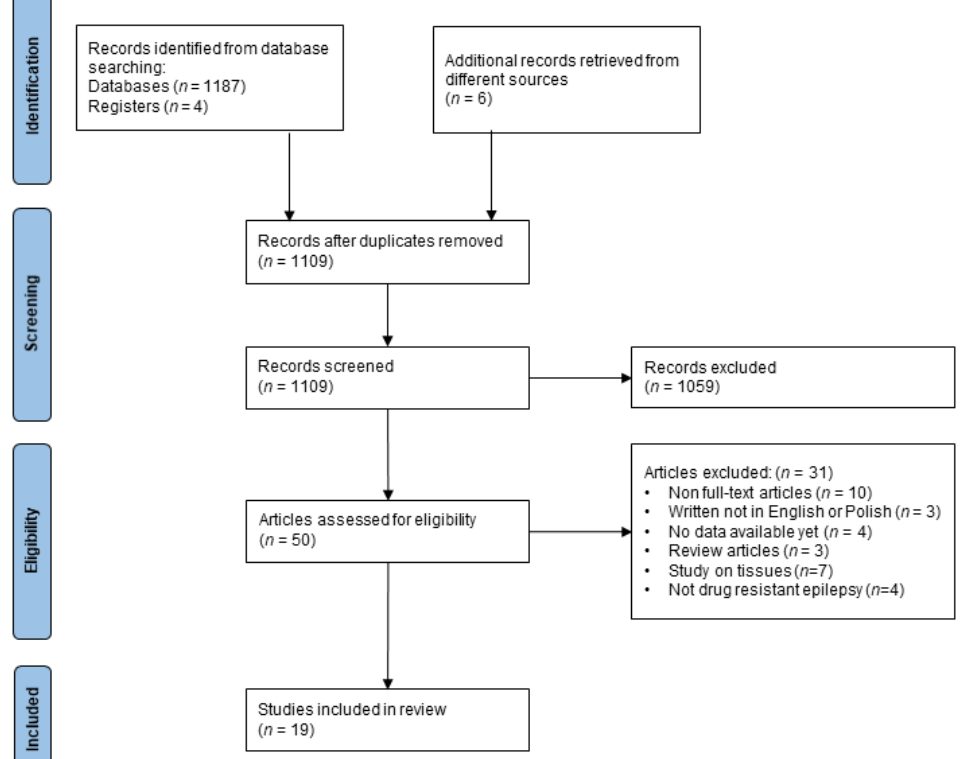
Figure 1. Flow diagram of the study selection.